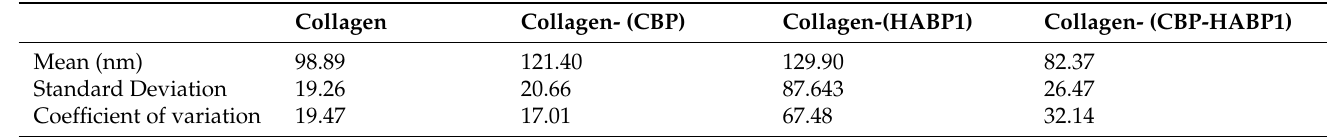
Figure 7. Collagen self-assembly examined through surface topography mapped via tapping mode AFM. Scale bar = 1 µ m. ( A ) Collagen, ( B ) CBP on collagen, ( C ) HABP on collagen, ( D ) CBP − HABP1 on collagen. Table 1. Statistics on fibril widths evaluated from AFM topographical